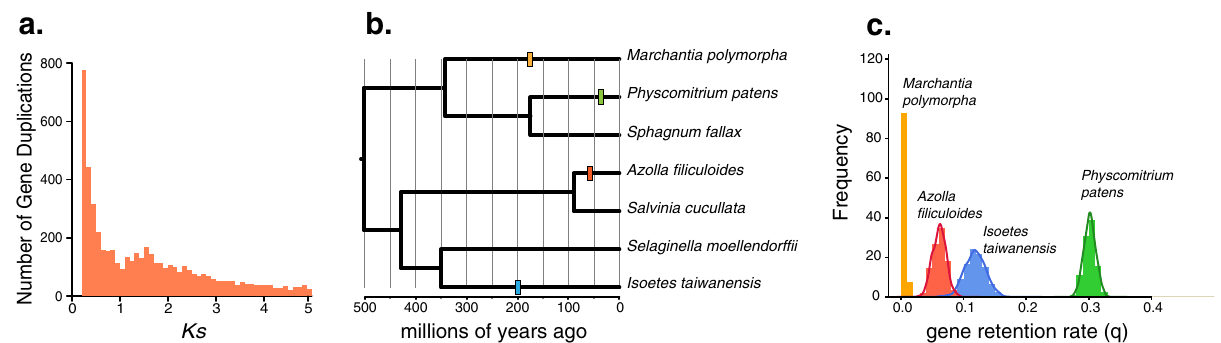
Fig. 2 Evidence for WGD in I. taiwanensis . a K s plot showing a peak centered on 1.8 corresponding to the ISTE β event. b Hypothesized WGD events that were tested (colored rectangles) in our WhALE analysis are shown on a phylogeny. c I. taiwanensis ’ posterior distribution of gene retention rates ( q ) falls between that of A. fi liculoides and P. patens , both are known to have at least one WGD. This provides additional support for the ISTE β event. Conversely, the gene retention rate is close to zero for M. polymorpha , consistent with its lack of WGD. Source data are provided as a Source Data fi